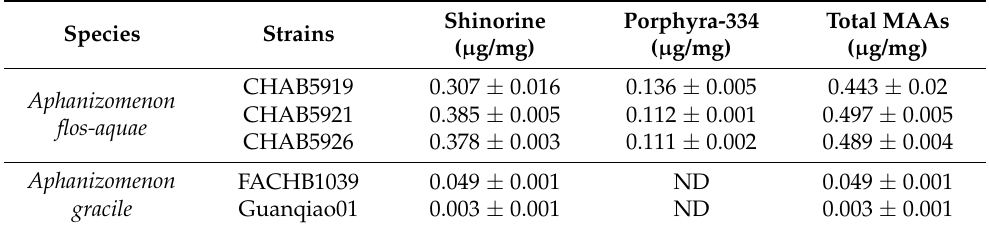
Table 3. MAAs concentration in Aphanizomenon strains (the MAAs content of all strains is expressed as µ g /mg, ND means not